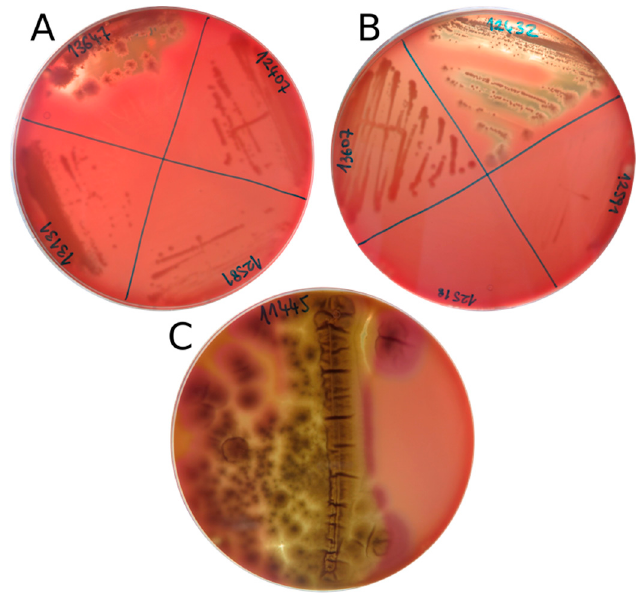
Figure 1. Beta-hemolytic phenotypes of the strains ( A ) Aureobasidium melanogenum (EXF-13647), ( B ) Aureobasidium pullulans (EXF-12432), and ( C ) Penicillium bialowiezense -like (EXF-11445) expressed at 15 °C.